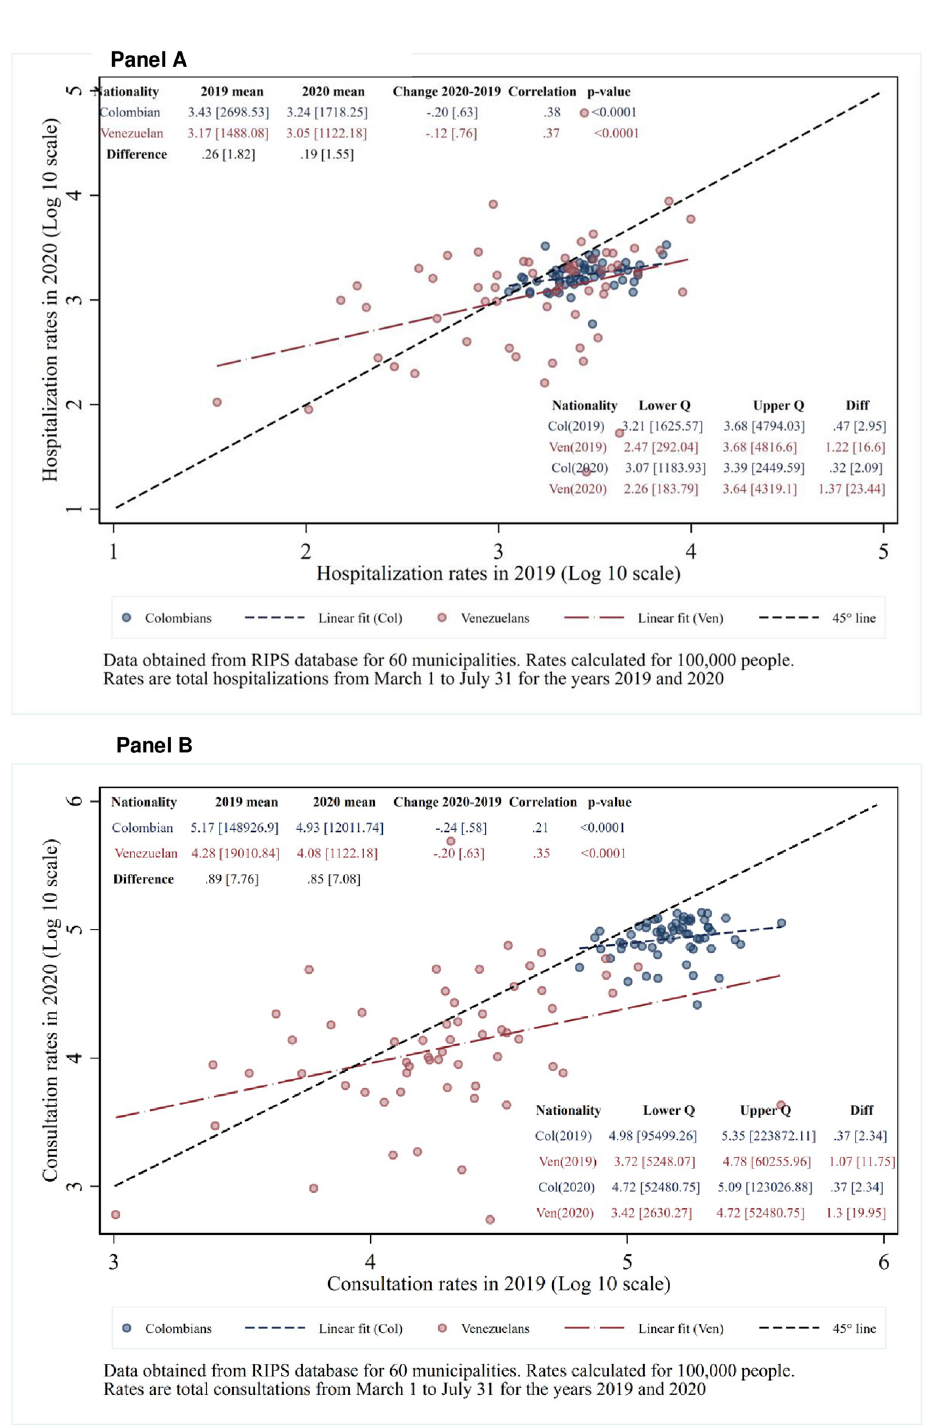
Fig 4. All-cause rates of Colombians and Venezuelans in 2020 versus 2019 for (A) hospitalizations and (B) consultations.